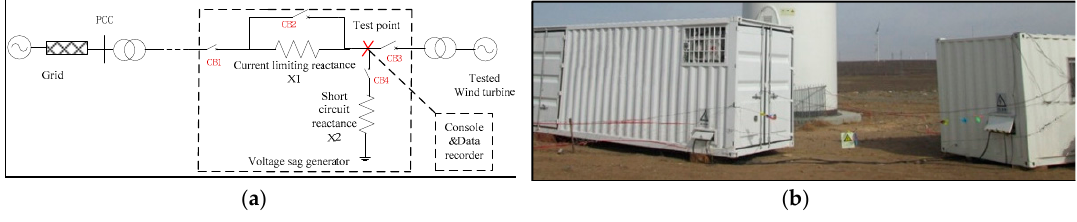
Figure 12. ( a ) LVRT test schematic diagram, ( b ) picture of the LVRT field test devices.